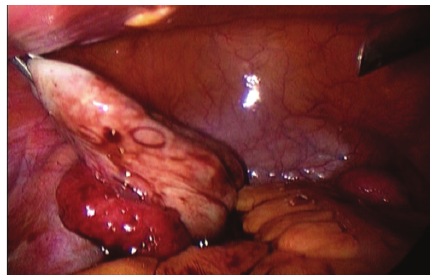
Figure 1: Endometrioma of the left ovary.